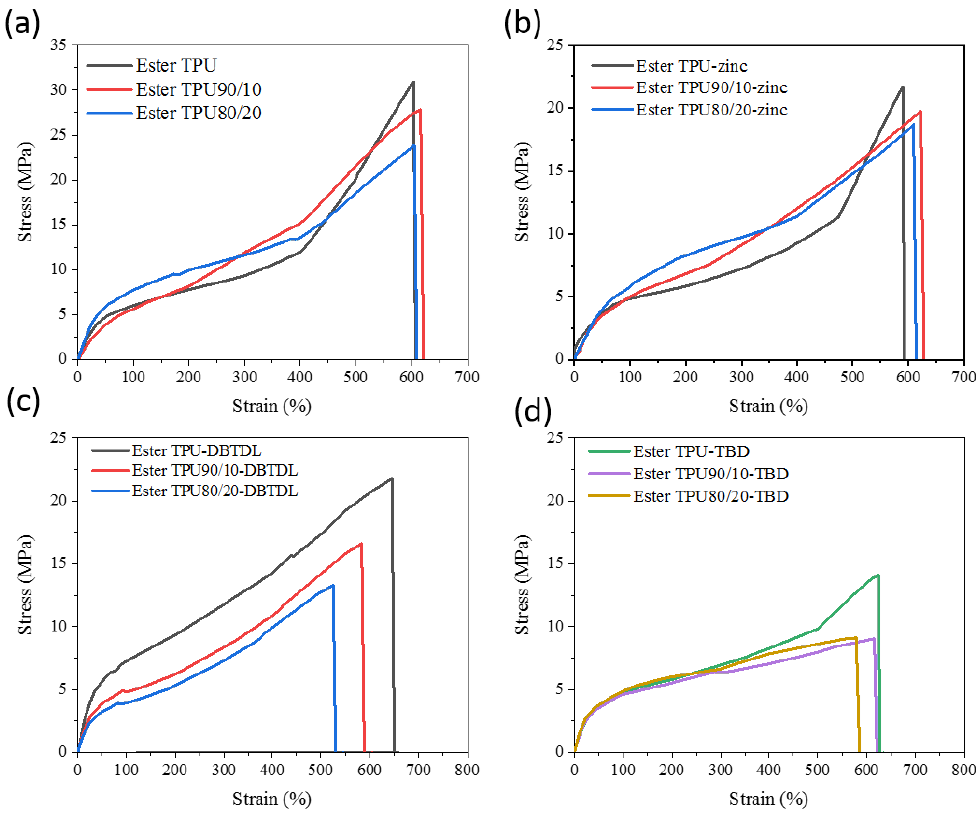
Figure 4. Stress-strain curves for the ester TPU / phenoxy resin blends: ( a ) ester TPU / phenoxy without the catalyst; ( b ) ester TPU / phenoxy with zinc acetate as the catalyst; ( c ) ester TPU / phenoxy with DBTDL as the catalyst; ( d ) ester TPU / phenoxy with TBD as the catalyst.